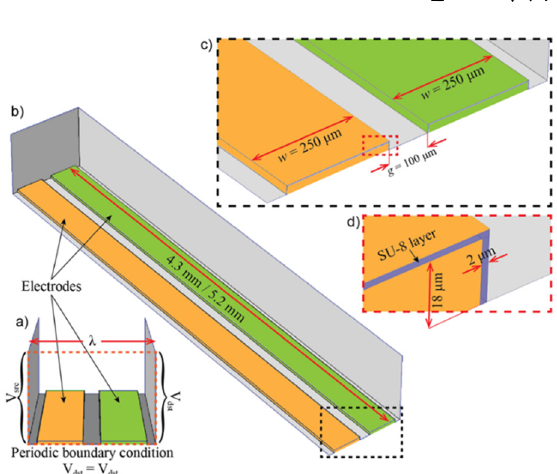
Figure 4. 3D geometric definitions and established boundary conditions for the finite element anal- ysis: ( a ) periodic section of IDEA; ( b ) full 3D geometric domain, where 𝑙 = 4.3 mm for IDEAs 1 and 2 and 𝑙 = 5.2 mm for IDEA 3; ( c ) inset showing electrode width and a gap between adjacent elec- trodes; and ( d ) inset showing electrode thickness and SU-8 layer thickness.